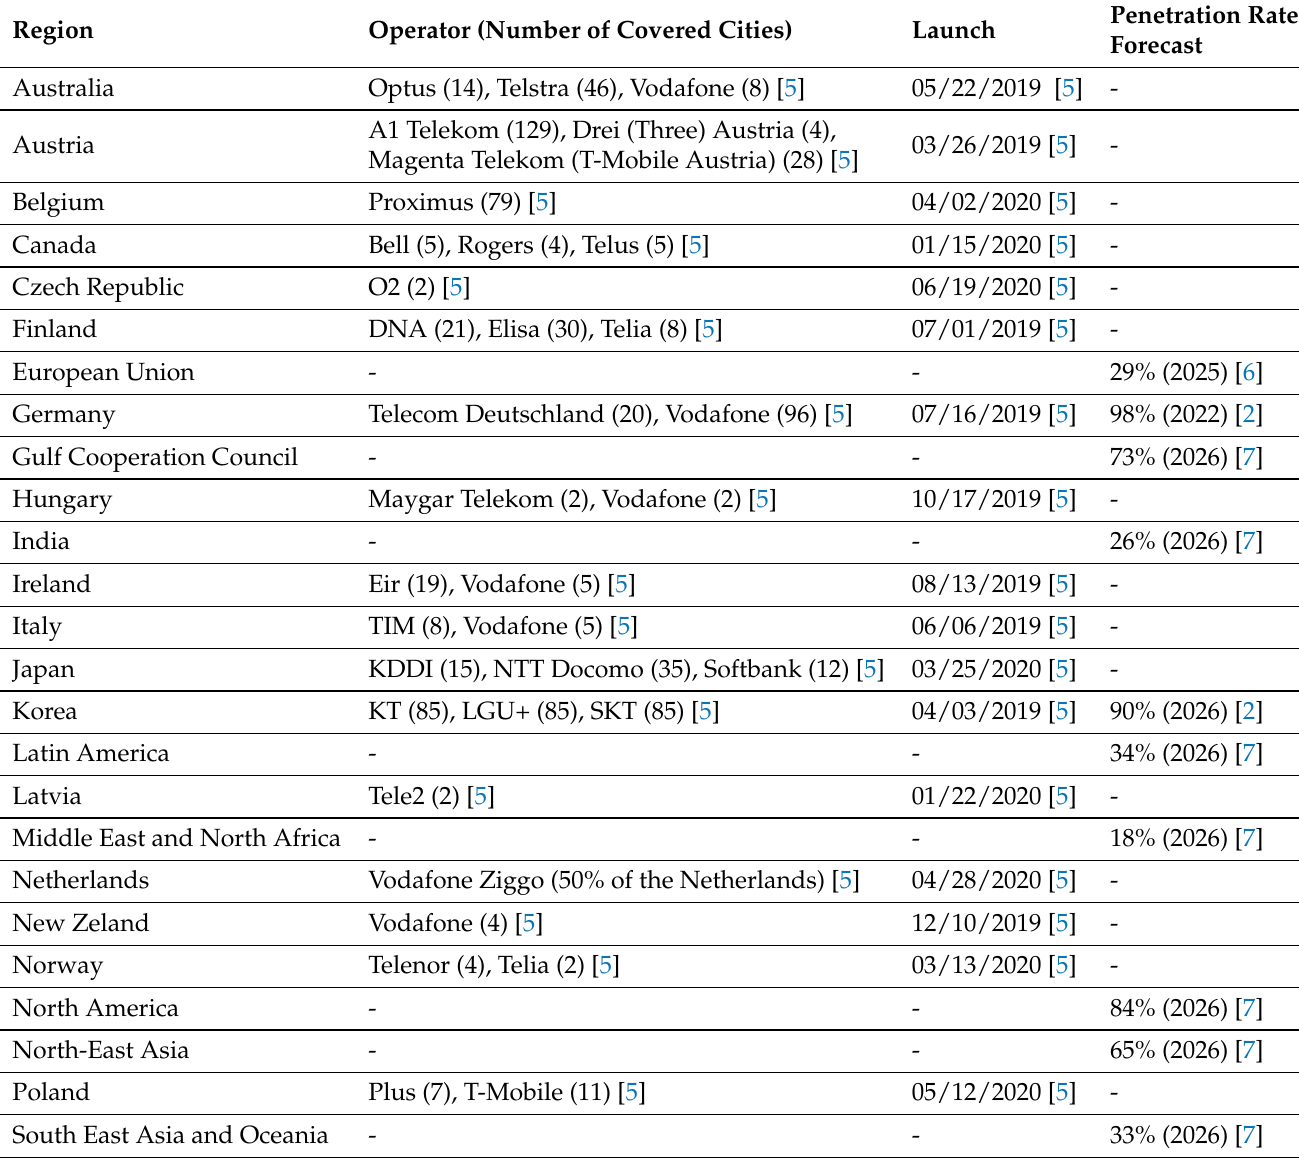
Table 1. Status of 5G deployment and